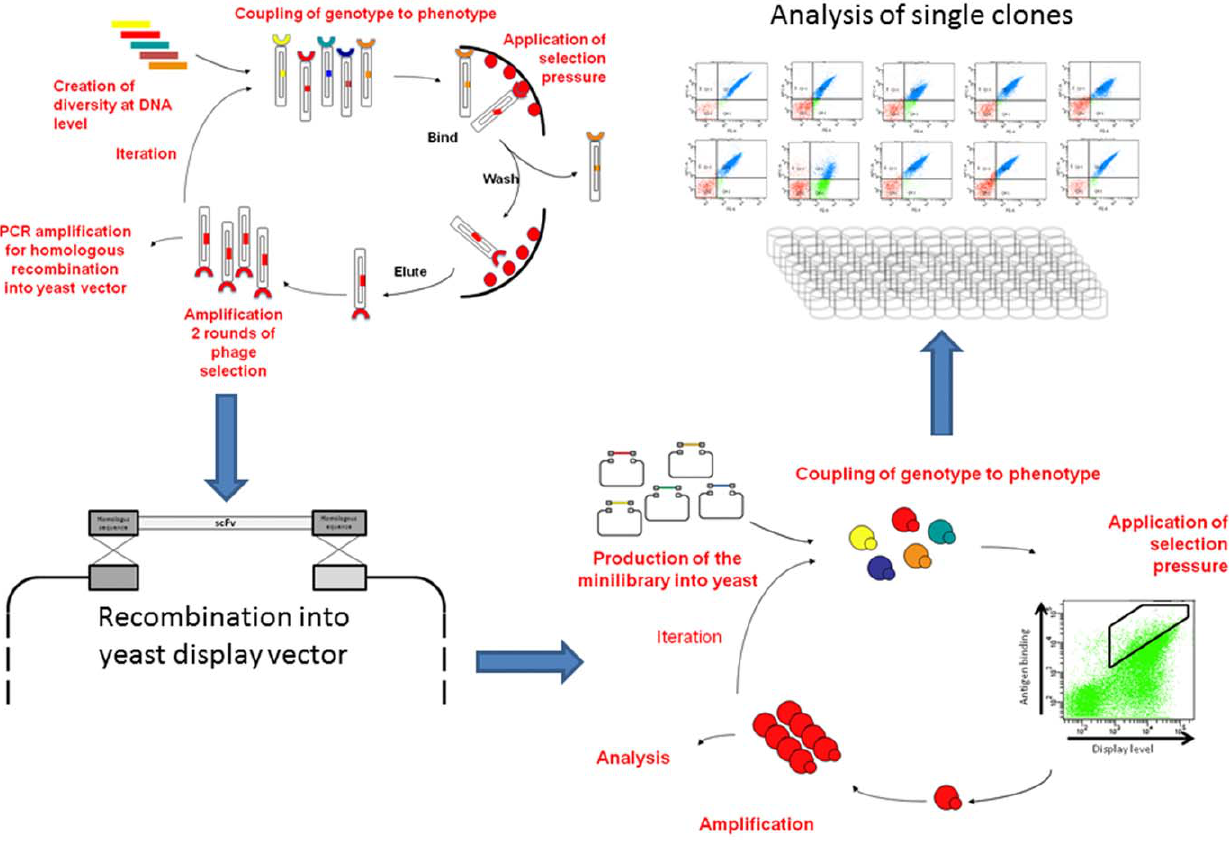
Figure 1. Strategy applied to the selection of antibodies using both phage and yeast display. Antibodies are first selected against Ag85 using two rounds of phage display, after which the whole selection output is cloned into a yeast display vector using homologous recombination. A further one or two rounds of sorting by flow cytometry allow the subsequent isolation and testing of single clones.